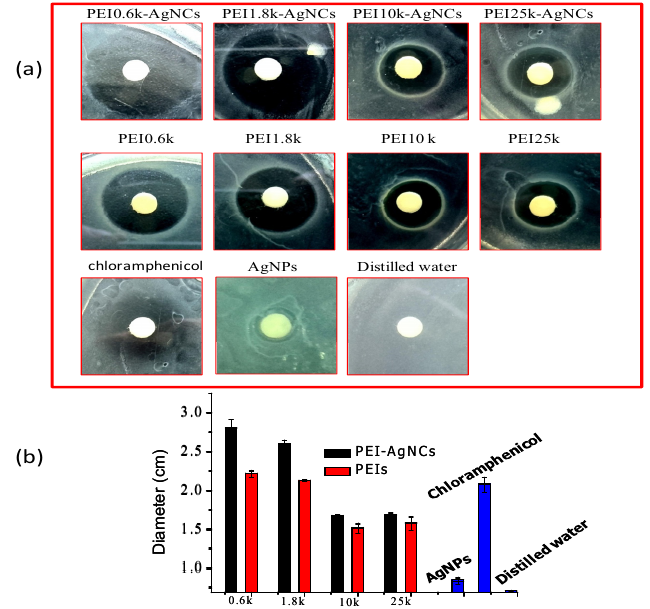
Figure 4. The inhibition zones yielded by PEI-AgNCs. PEIs, AgNPs and the positive and negative controls for E. coli . ( a ) Their images. The size of each image is 3 cm × 3 cm; ( b ) The statistic results of the diameters of these zones.